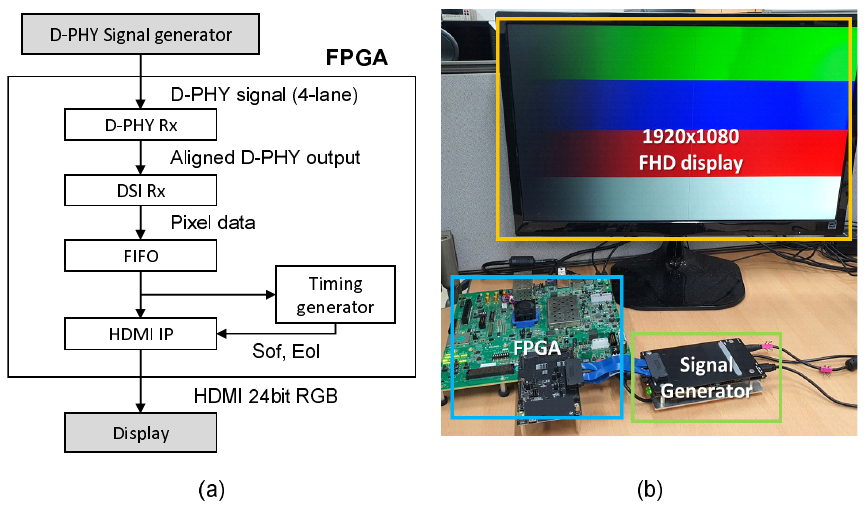
Figure 9. The verification setup on FPGA. ( a ) A block diagram. ( b ) The output on display using a test input from a signal